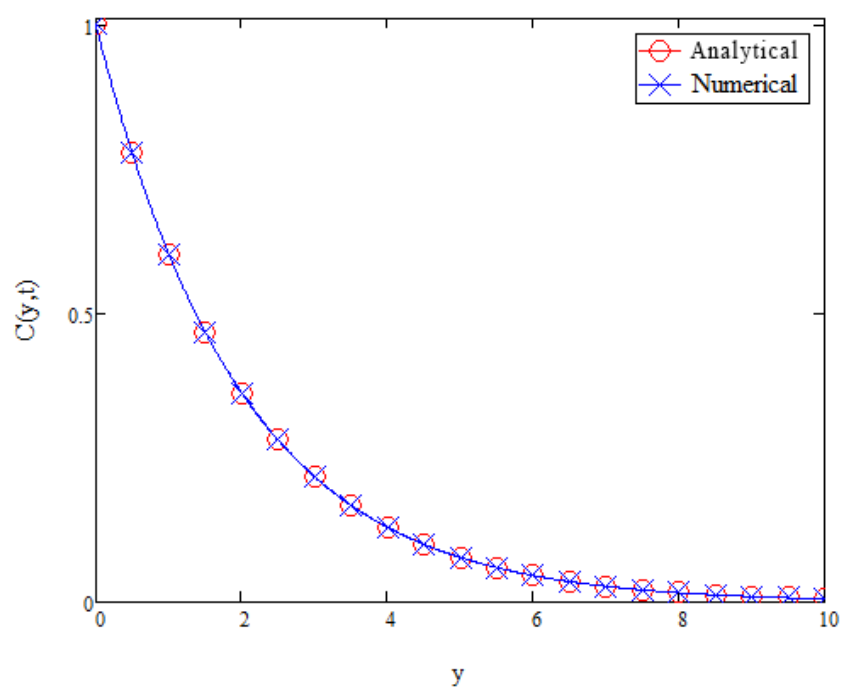
Figure 4. Concentration profile for analytical solution presented in Equation (22) validated with numerical solution using Zakian’s method.